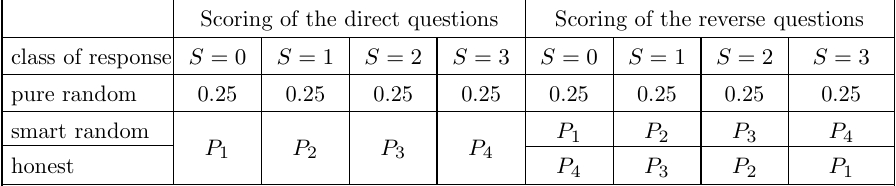
Table 2. The assumed relations between distributions of scoring in the honest and random classes of responses to the direct versus reverse questions of the CES-D